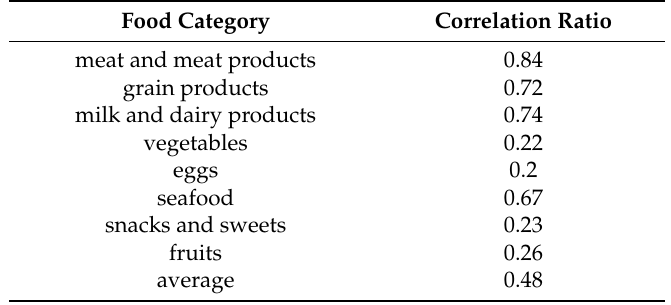
Table 8. Description of cluster analysis: protein sources as classification features.